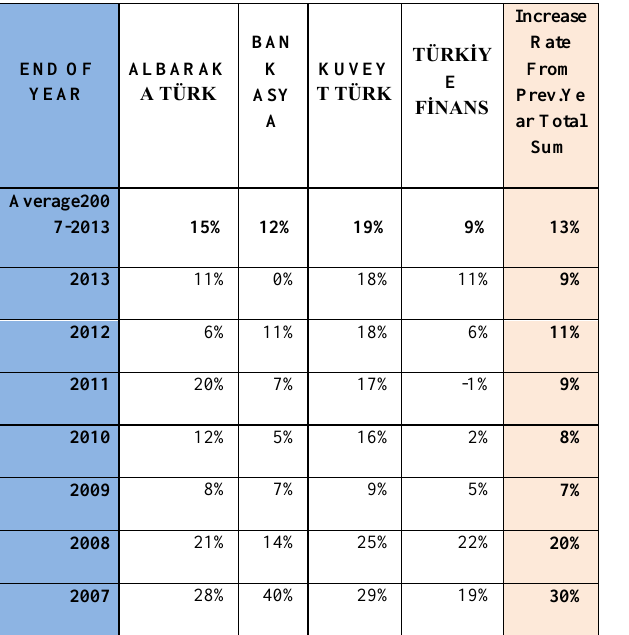
Table-5/b: Increase Rate from Previous Year at Personnel Number (Participation Banks), 2007-2013